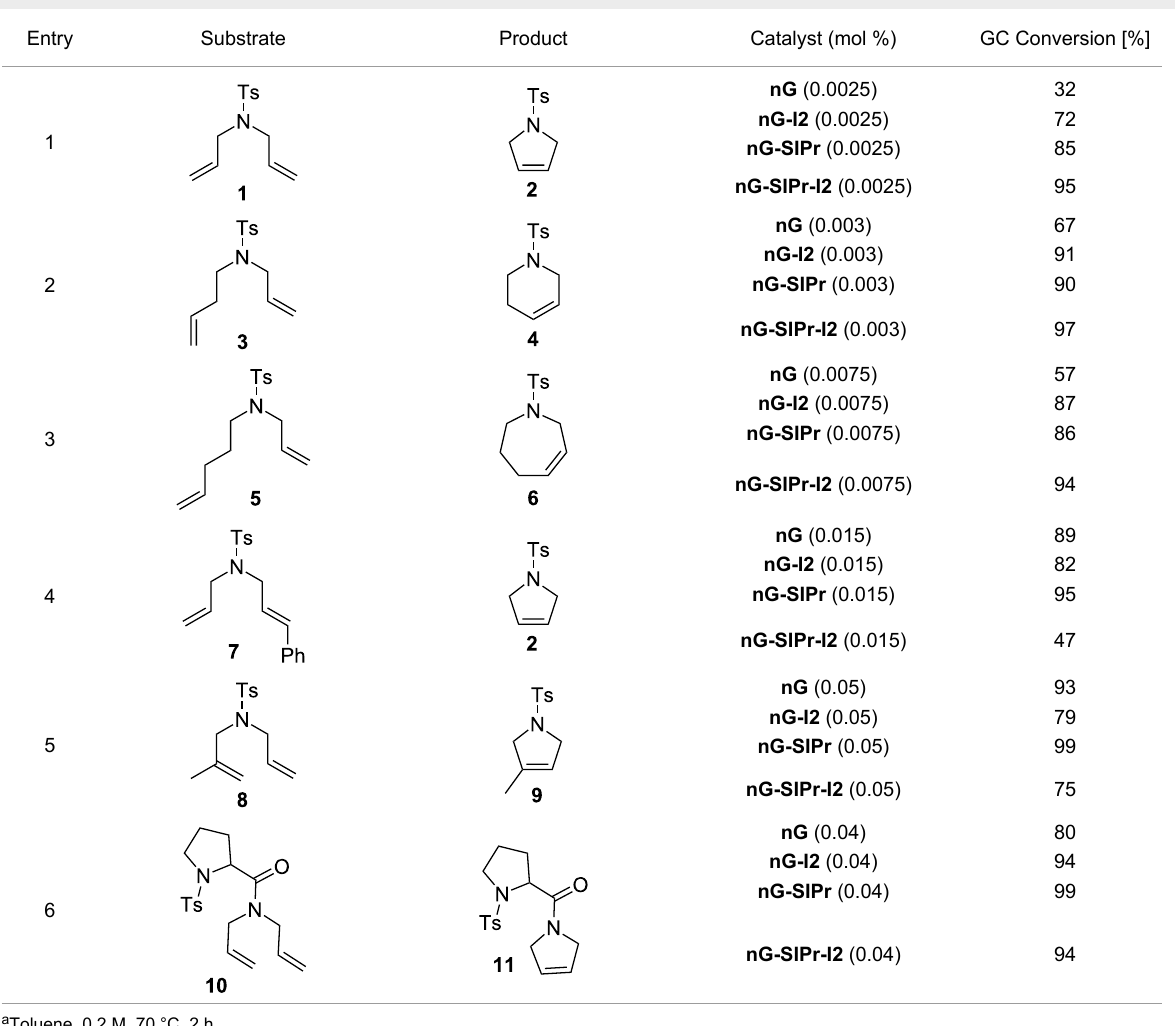
Table 1: Results of RCM reactions.